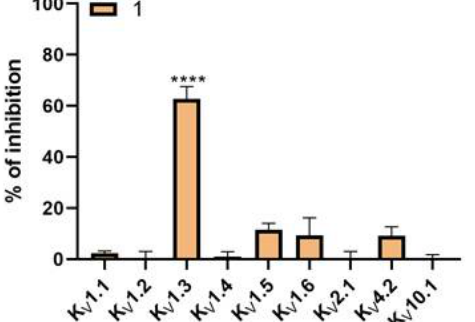
Figure 4. Selectivity determination of PAP-1 ( 1 ) screened at a concentration of 10 µM (HiClamp Xenopus laevis heterologous expression system) on a panel of ion channels. (**** p < 0.0001, Mean ± S.E.M, N = 3–12).